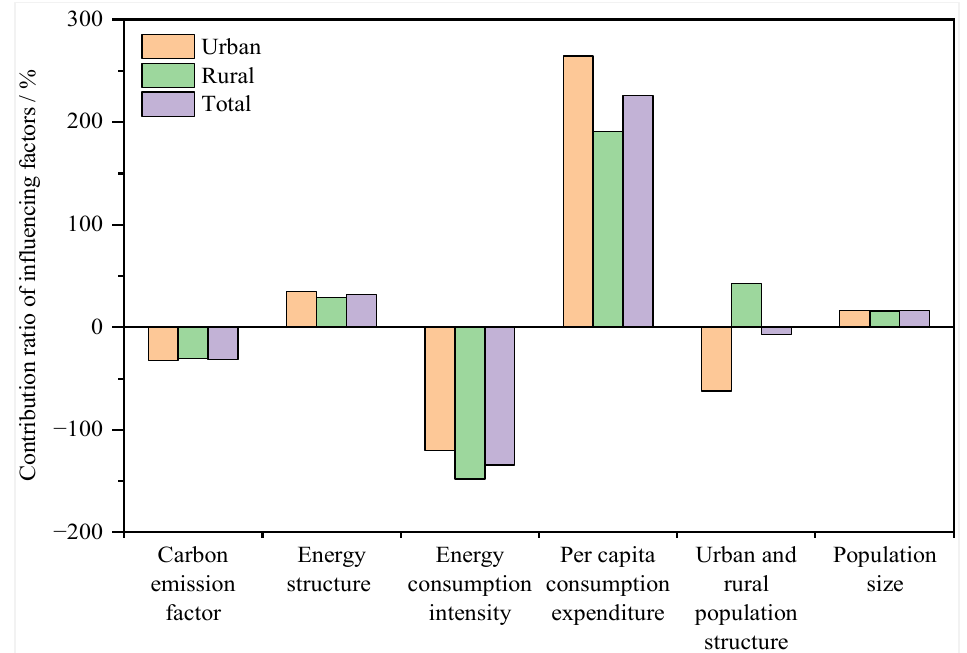
Figure 7. Contribution of influencing factors to direct CO 2 emissions from household consumption in Fujian Province from 2006 to 2018.